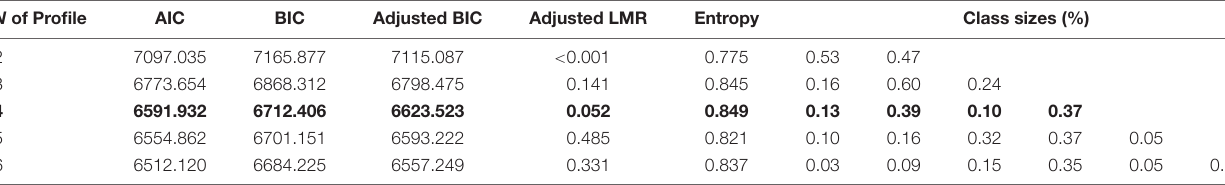
TABLE 2 | Latent profile